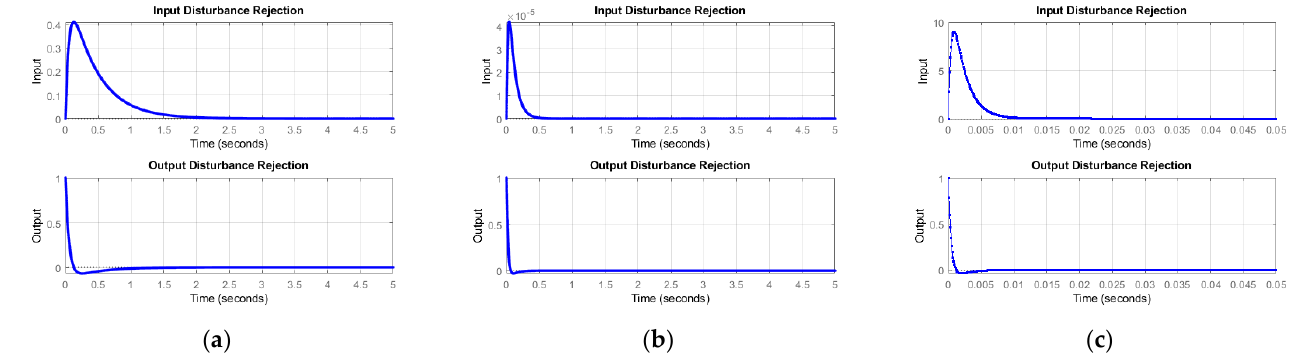
Figure 9. Closed – loop disturbance rejection response of ( a ) speed controller, ( b ) flux controller, and ( c ) current controller. Table 3. IFOC control of IM.